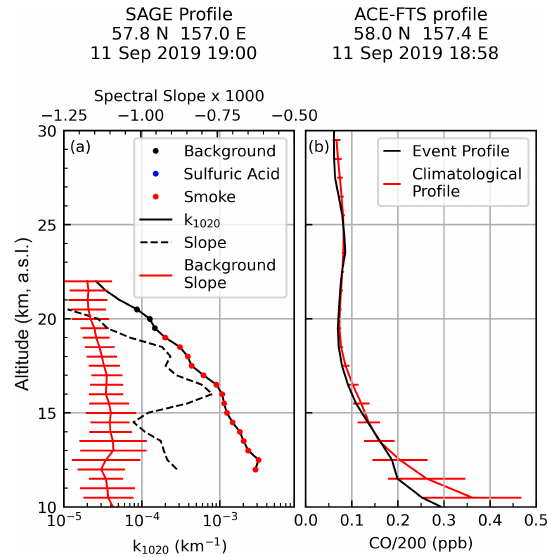
Figure 18. ACE-FTS profiles of CO (a, d, g, j) , HCN (b, e, h, k) , and SO 2 (c, f, i, l) collected within 2 months of the Raikoke erup- tion. The climatological profiles present the mean ± 1 standard de- viation for data collected within the specified latitude ( ± 2.5 ◦ ) for July–August–September over the lifetime of the ACE-FTS instru- ment. The open circles indicate the highest altitude at which the carbonyl stretch was identified (Chris Boone, personal communica- tion, February 2022). Table 5. Size and distribution width estimates of the particles that were classified as smoke in Fig. 19. Estimates were made using the ACE-FTS retrieval (provided by C. Boone, personal communica- tion), the Wrana et al. (2021) method (provided by Felix Wrana, personal communication, 15 February 2022), and information from Fig. 1b. Estimation method Radius range (nm) σ range ACE-FTS 197–230 1.3–1.4 Wrana 135 1.6–1.8 Inferred from Fig. 1 180–220 1.5